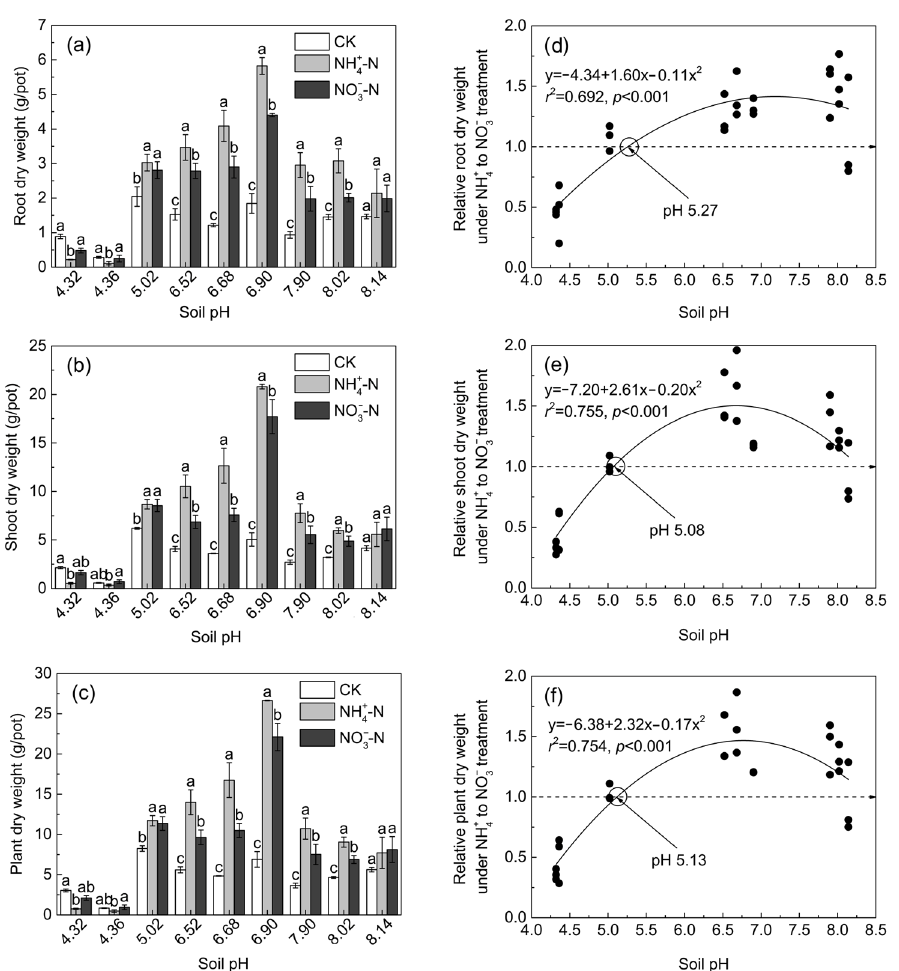
Figure 1. Maize seedlings after 30 days of growth with non-N (CK), NH 4+ , or NO 3− at different soil pHs.